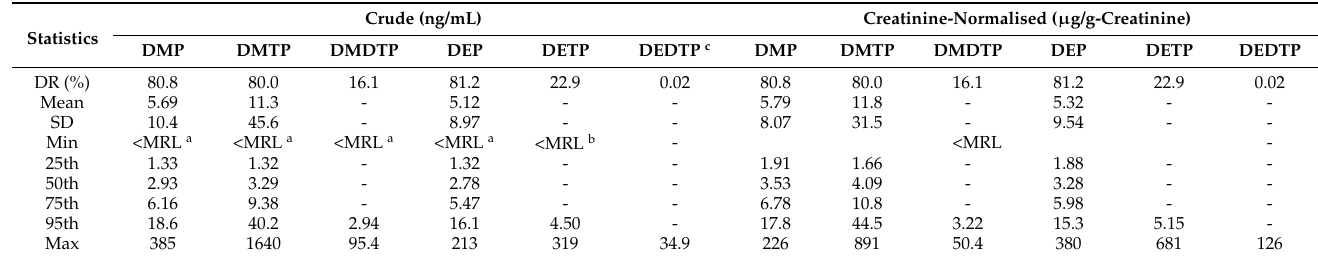
Table 1. Urinary DAP concentrations ( n = 4575).